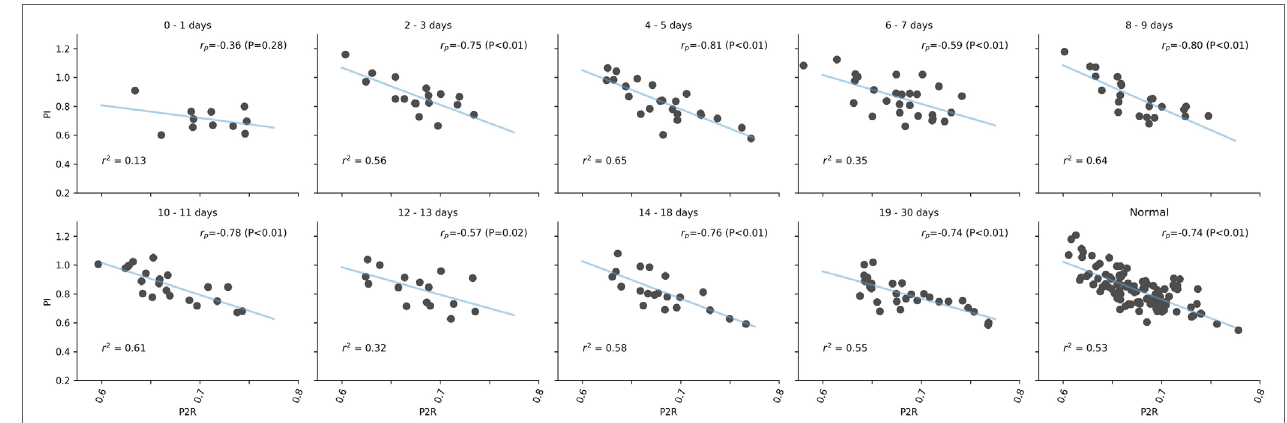
FigUre 4 | Correlation analysis between pulsatility index (PI) and P2R over different days post-injury. The linear fit, blue line, and r 2 values are given for each set of values. Pearson’s r values are presented with corresponding P values in the upper right of each